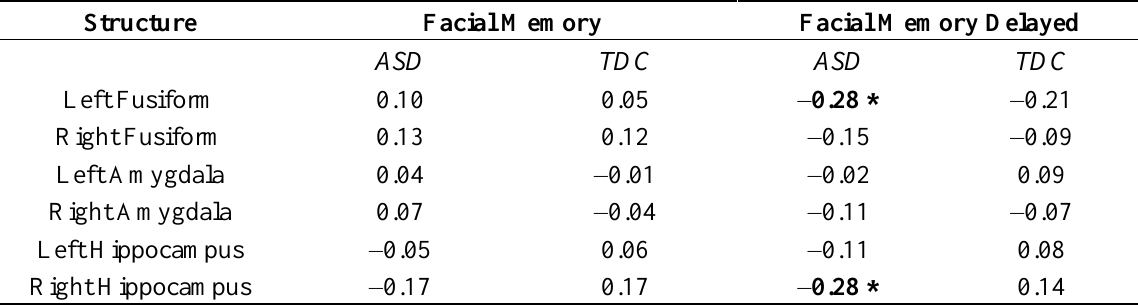
Table 4. Partial Correlations between facial memory ROI volumes and TOMAL performance–controlling for TICV and age.